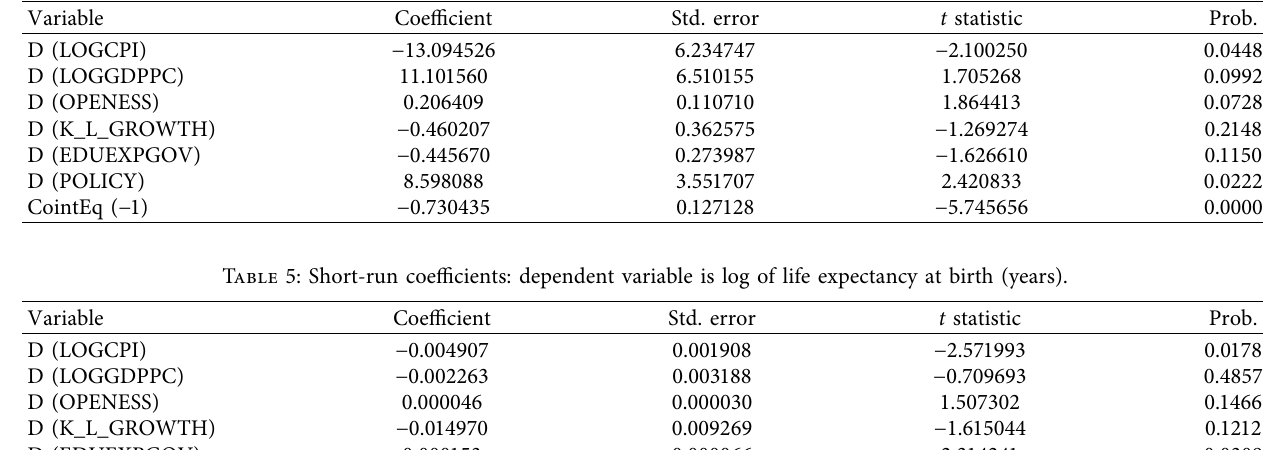
Table 4: Short-run coefficients: the dependent variable is the years of schooling.